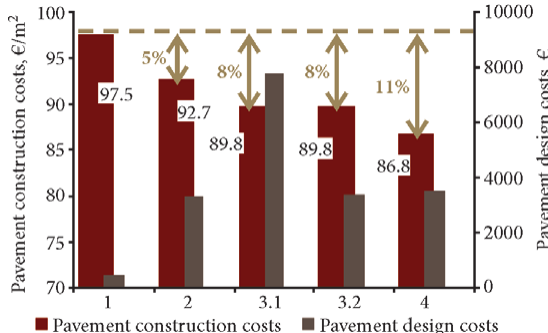
Fig. 9. The costs comparison of pavement construction and pavement